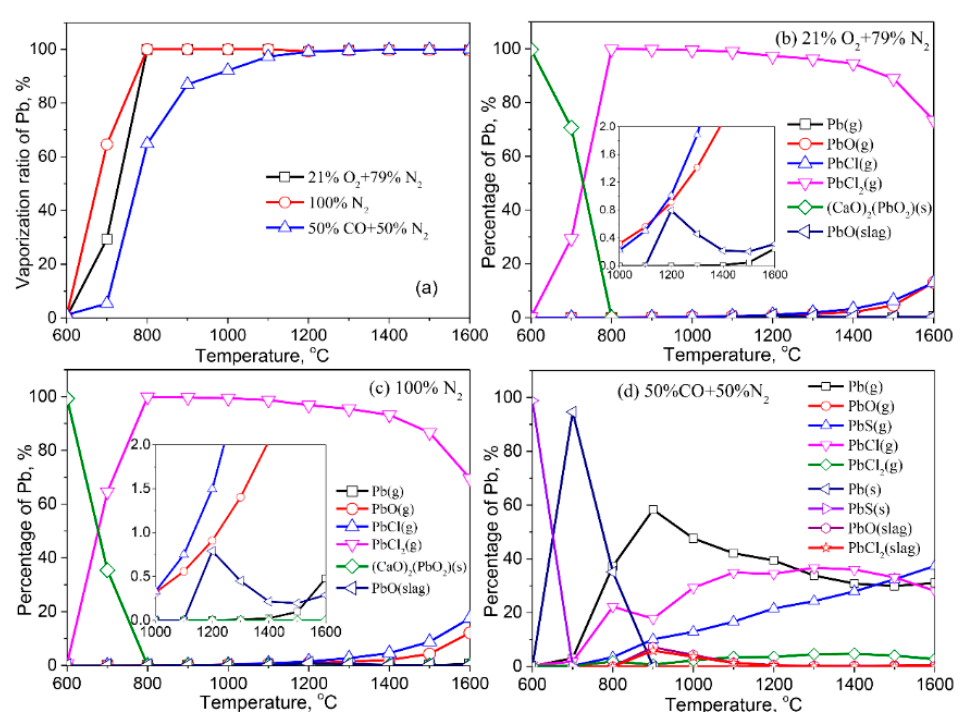
Figure 4. Vaporization behavior of Pb under different atmospheres. ( a ) Vaporization ratio of Pb as a function of temperature in different atmospheres; ( b ) Distribution of Pb in 21%O 2 plus 79%N 2 ; ( c ) Distribution of Pb in 100%N 2 ; ( d ) Distribution of Pb in 50%CO plus 50%N 2 .